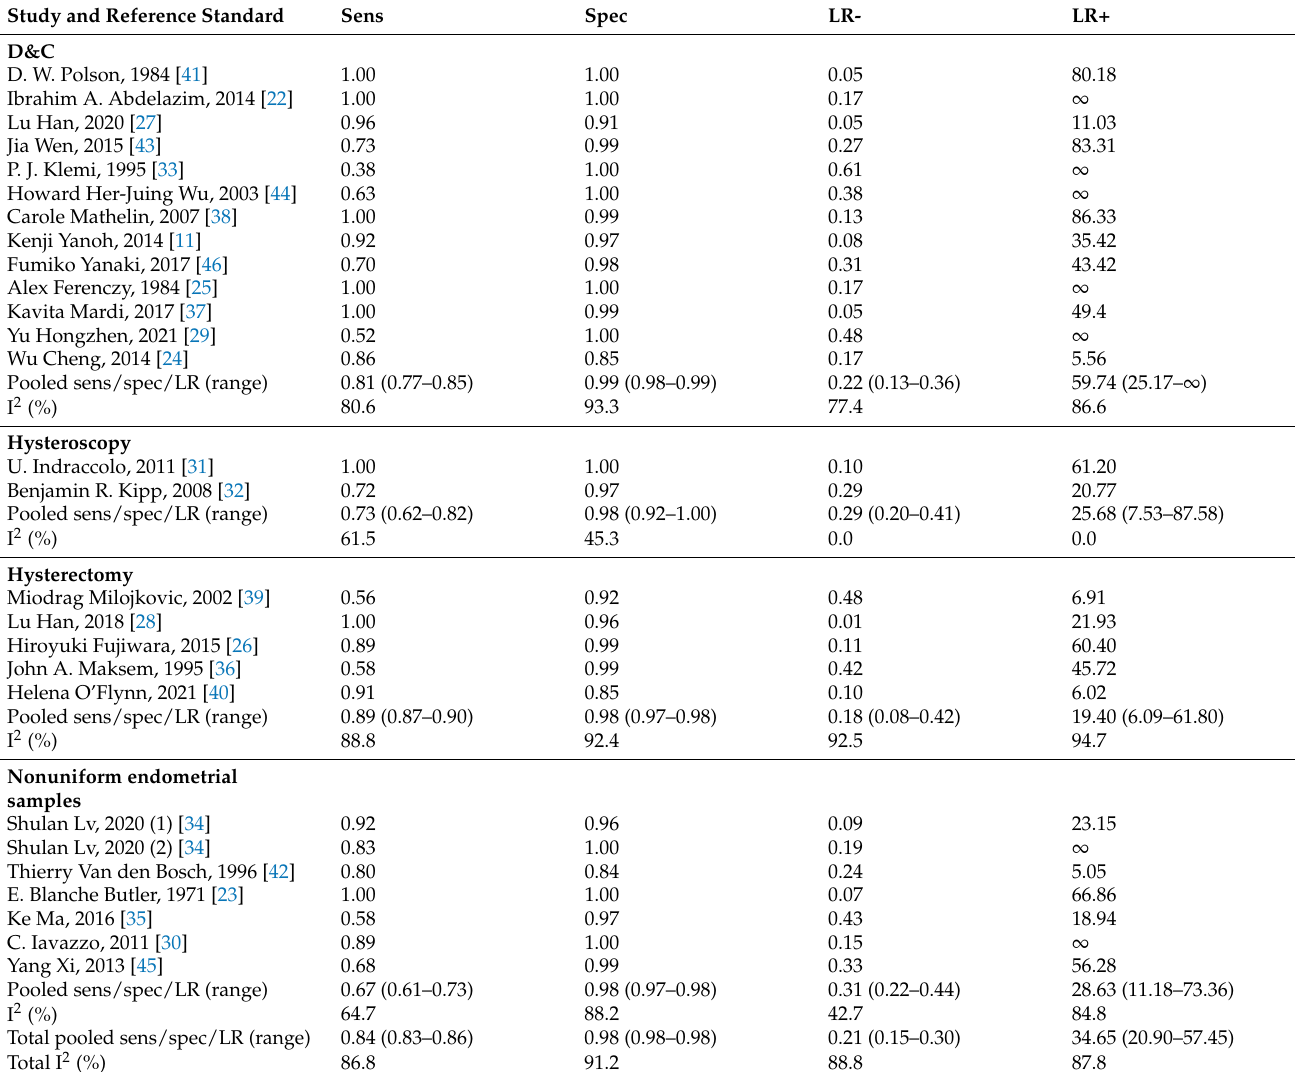
Table 2. Diagnostic accuracy of ECT using different reference